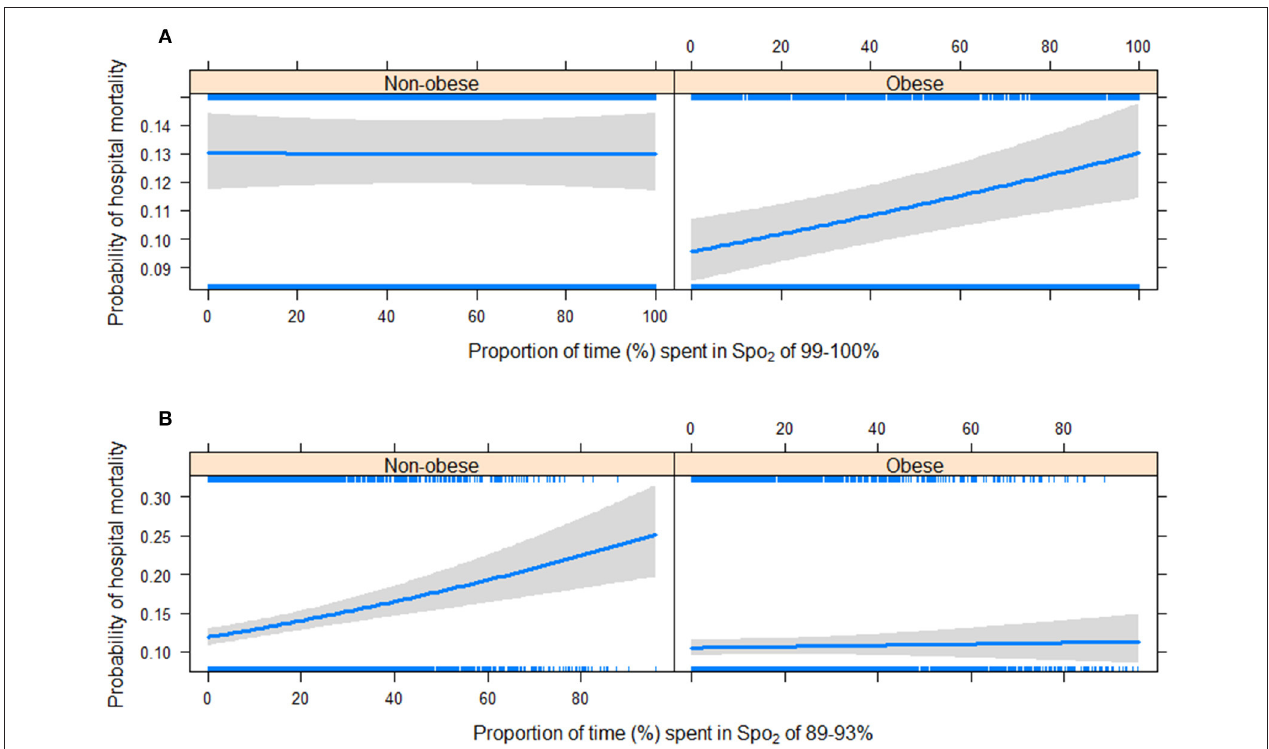
FIGURE 3 | Interaction between PTS-Spo 2 and obesity status (obese and non-obese). Upper (A) While the PTS-Spo 2 of 99–100% was not significantly associated with hospital mortality outcome (OR 1.004; 95% CI 0.990–1.018; p = 0.597; per 10% increase) in non-obese patients, it was associated with increased risk of mortality in obese patients (OR 1.028; 95% CI 1.010–1.046; p = 0.002; per 10% increase). Lower (B) While the PTS-Spo 2 of 89–93% was significantly associated with increased risk of hospital mortality outcome (OR 1.089; 95% CI 1.051–1.128; p < 0.001; per 10% increase) in non-obese patients, it was not associated with hospital mortality in obese patients (OR 1.022; 95% CI 0.985–1.060; p = 0.235; per 10% increase). PTS-Spo 2, proportion of time spent in peripheral oxygen saturation, OR odds ratio, CI confidential